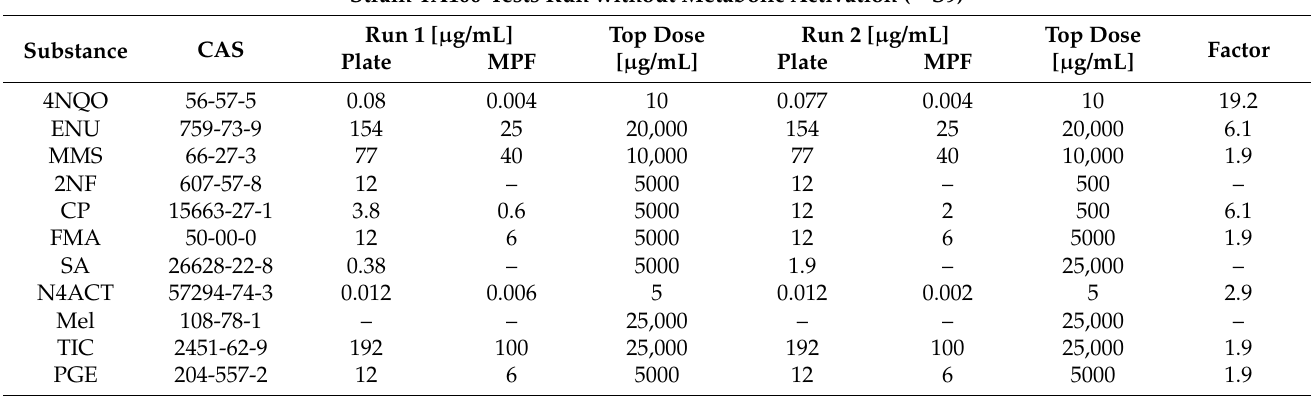
Table A1. Comparison of individual results of two independent test runs in the Ames MPF™ protocol with the standard agar-based Ames test. The concentration in µ g/mL represents the concentration during the exposure step. The top dose is presented as µ g/mL in the sample. Each substance was tested in eight concentrations in half logarithmic dilution steps.